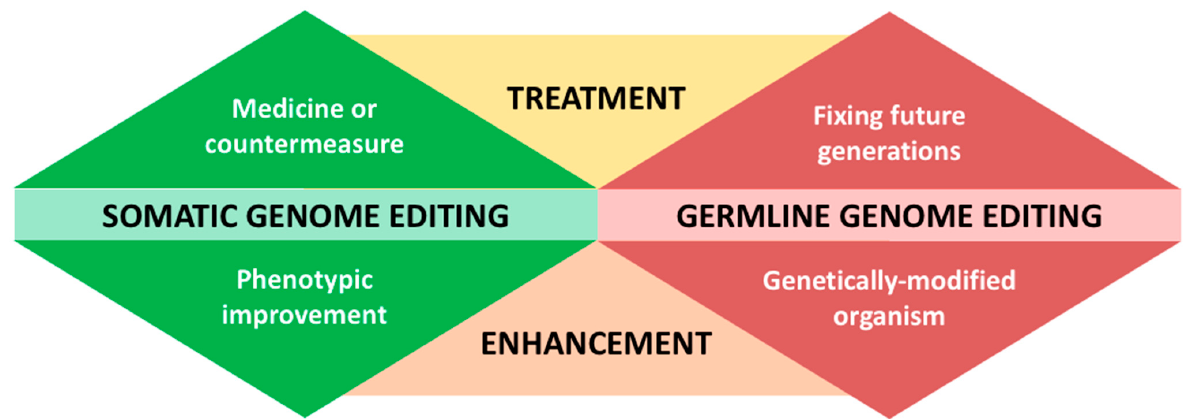
Figure 3. The differences between somatic and germline genome editing.